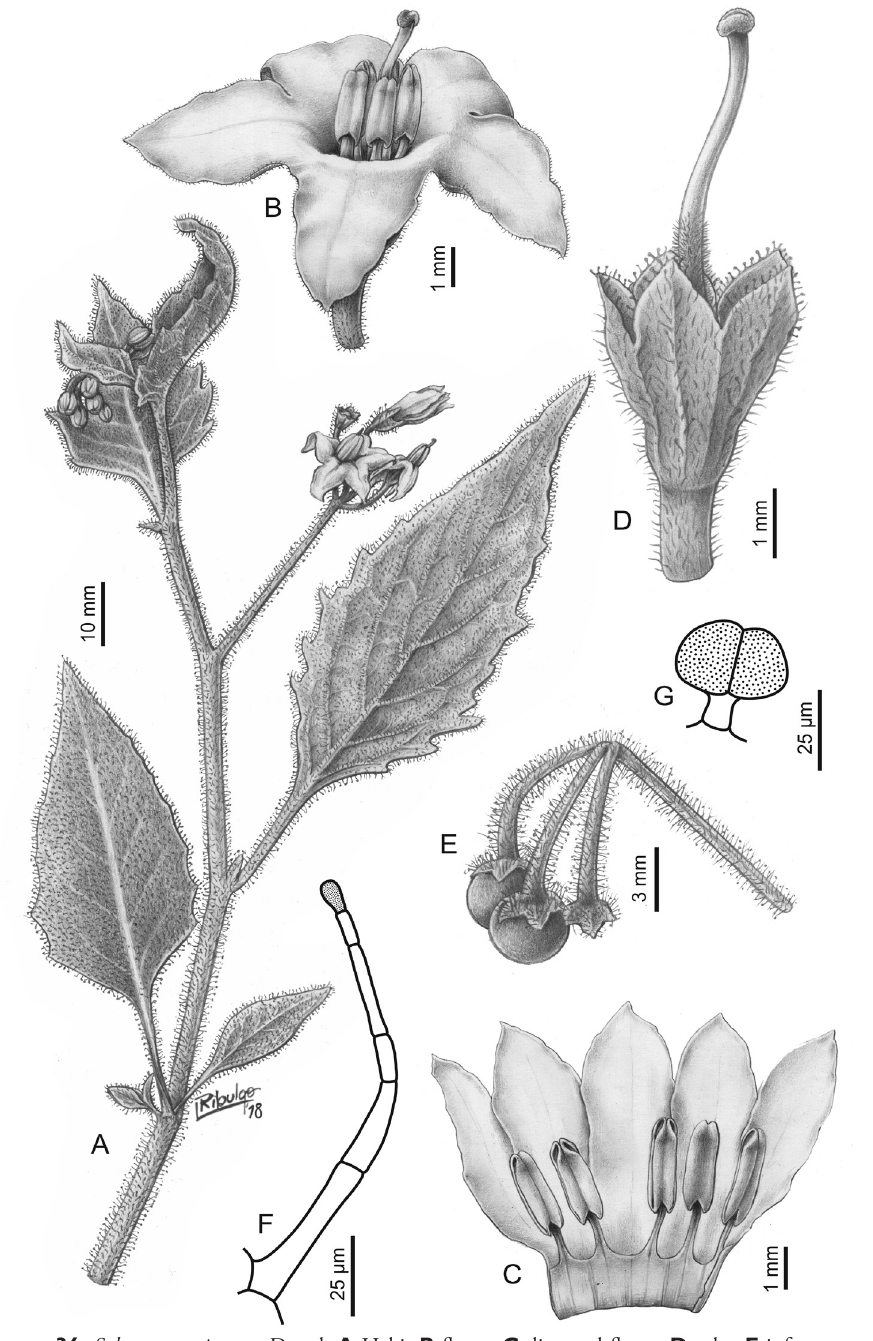
Figure 36. Solanum pruinosum Dunal. A Habit B flower C dissected flower D calyx E infructescence F elongate glandular trichome G sessile glandular trichome ( A–E Amith JDA-30248 ; F–G Ventura A. 2588 ). Drawing by L.